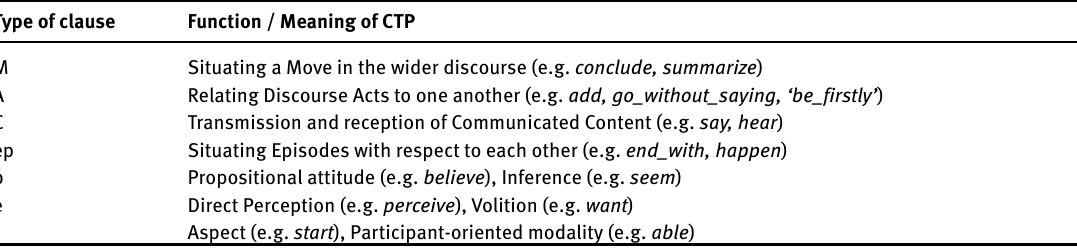
Table 1. Classification of CCs according to Entity type (Hengeveld & Mackenzie 2008: 363) Type of